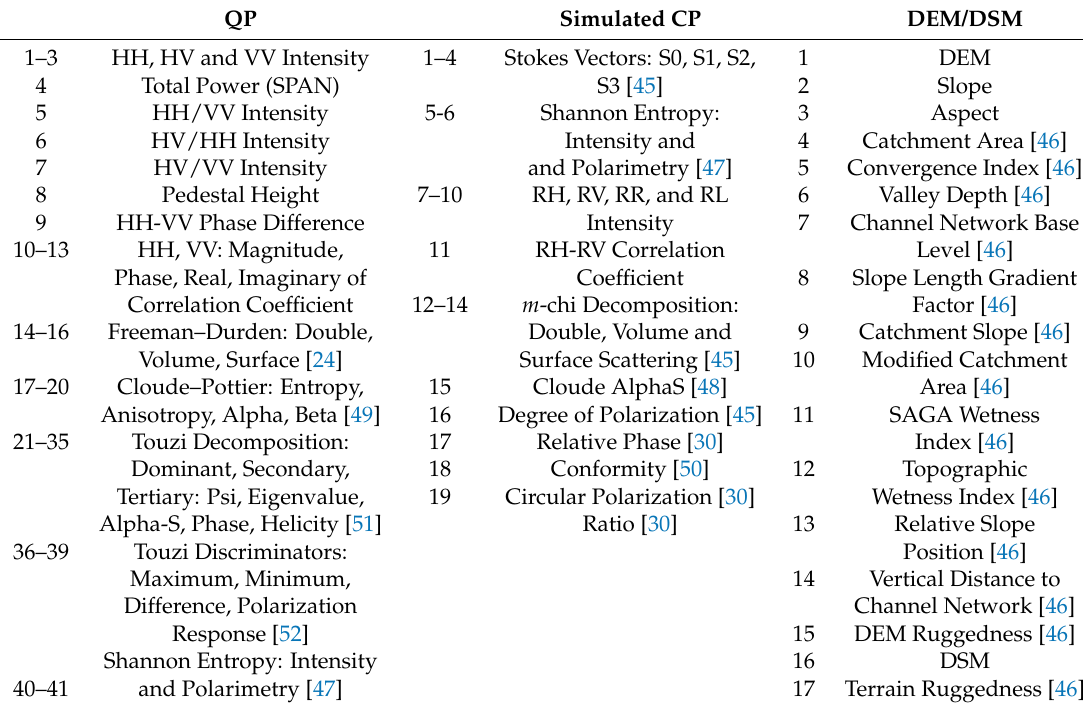
Table 3. List of variables generated from each dataset for use in constructing RF